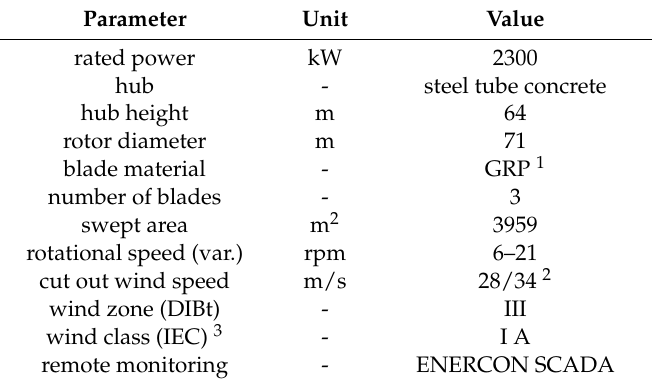
Table 1 contains the values of construction ‐ operational parameters for ENERCON E ‐ 70 wind turbines, used at Gorona del Viento on El Hierro [46]. Table 1. Parameters of ENERCON E ‐ 70 E4 wind turbines. Table 1. Parameters of ENERCON E-70 E4 wind turbines.